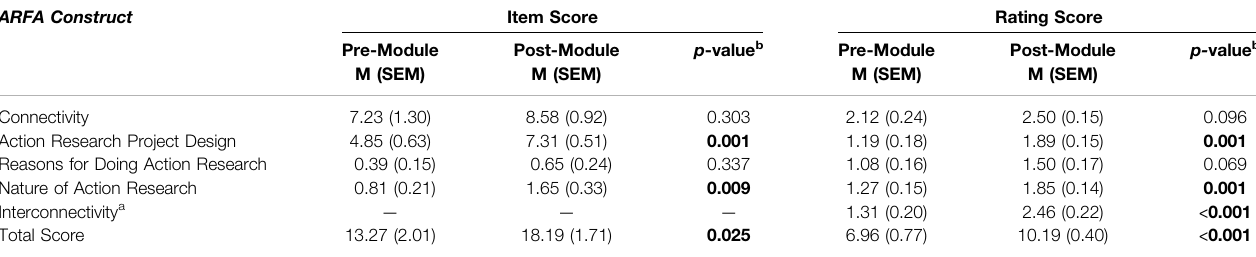
TABLE 5 | Student performance on the Action Research Flowchart Assessment